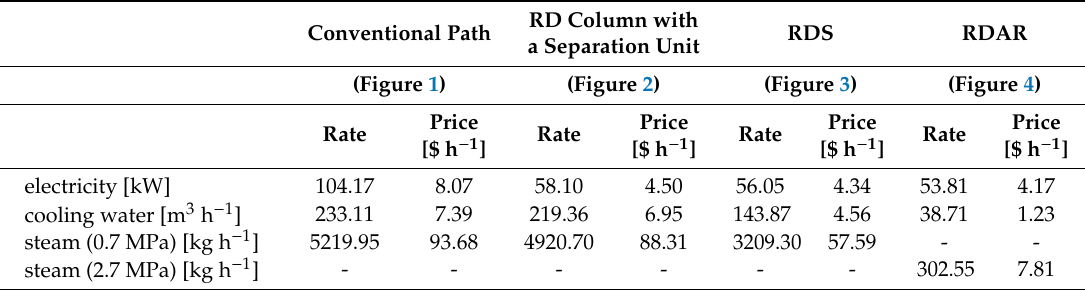
Table 11. Utility costs of designed ethyl acetate production